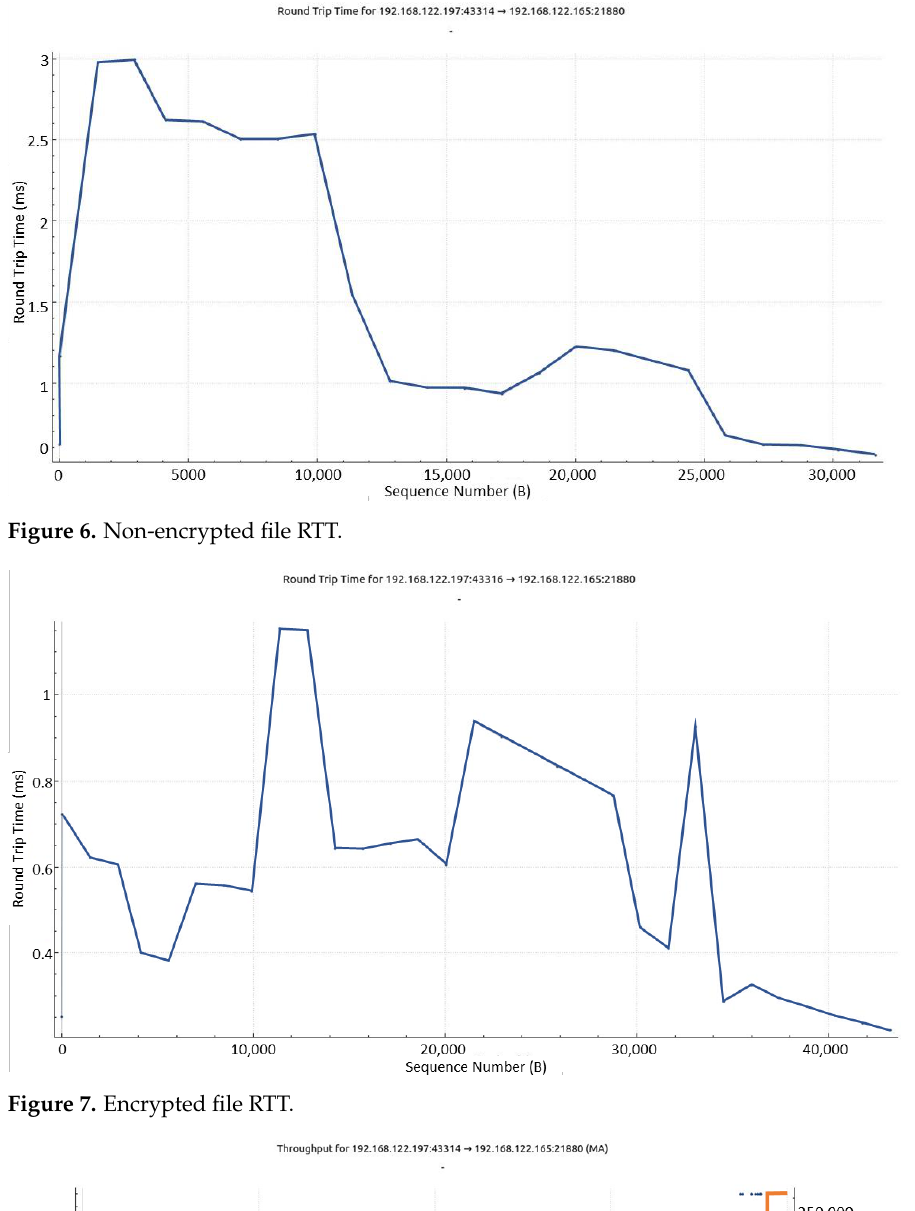
Figure 7. Encrypted file RTT.